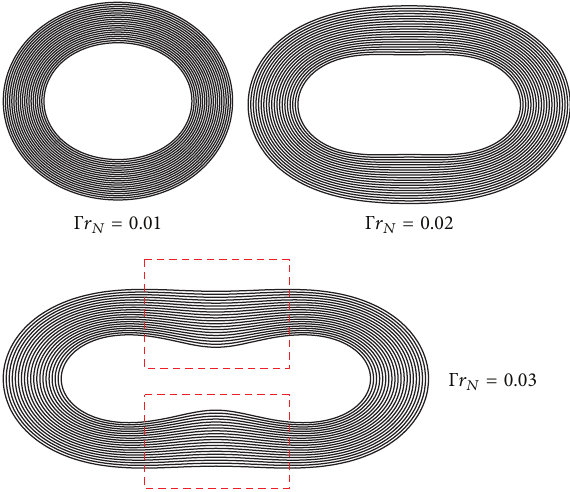
Figure 5: Variation in the cross-sectional view with increasing the curvature Γ of the cylinder’s axis. The parameters of 𝑁 = 20 and /𝐸 = 0.1 are 𝑘𝑟 𝑁